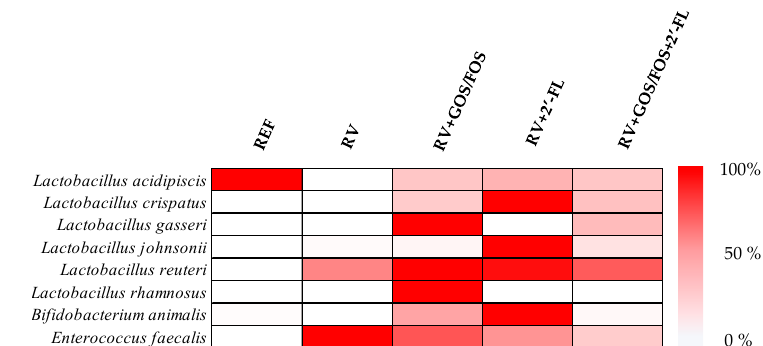
Figure 6. Analysis of the main bacterial species with probiotic activity found in the fecal microbiota at the peak of diarrhea (day 8): The heat map displays the relative abundance of bacteria with probiotic activity, where the group with the highest abundance was set at 100% and the group with the lowest abundance was set at 0%. The results were derived from n = 3 / group.